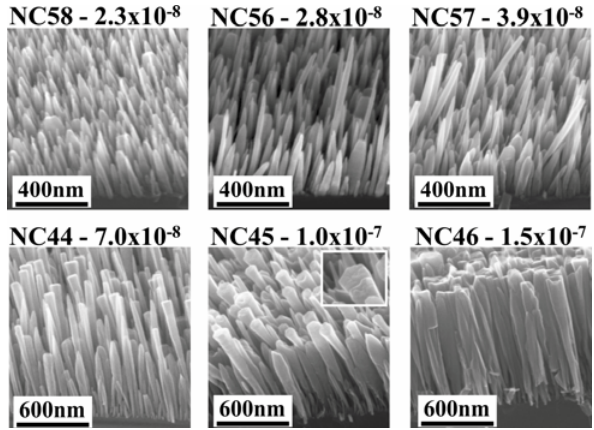
Figure 2. Morphology of molecular beam epitaxy (MBE) grown InN NWs on Si(111) at 475 °C at different in-fluxes. With permission from